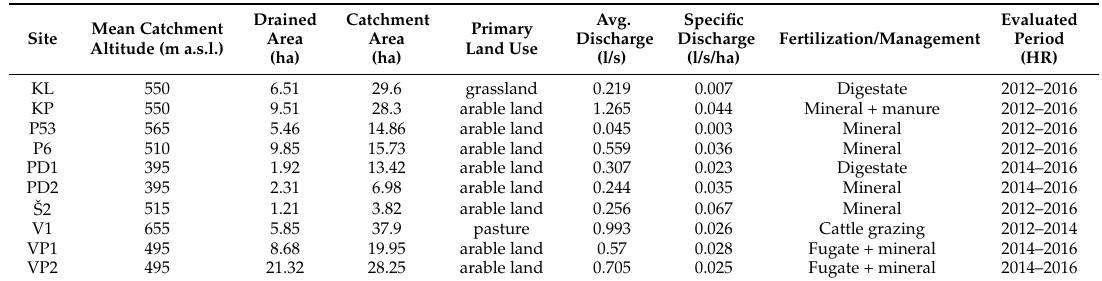
Figure 1. Characteristics and location of the monitored sites in the Czech Republic. Table 1. Basic characteristics of the monitored sites.